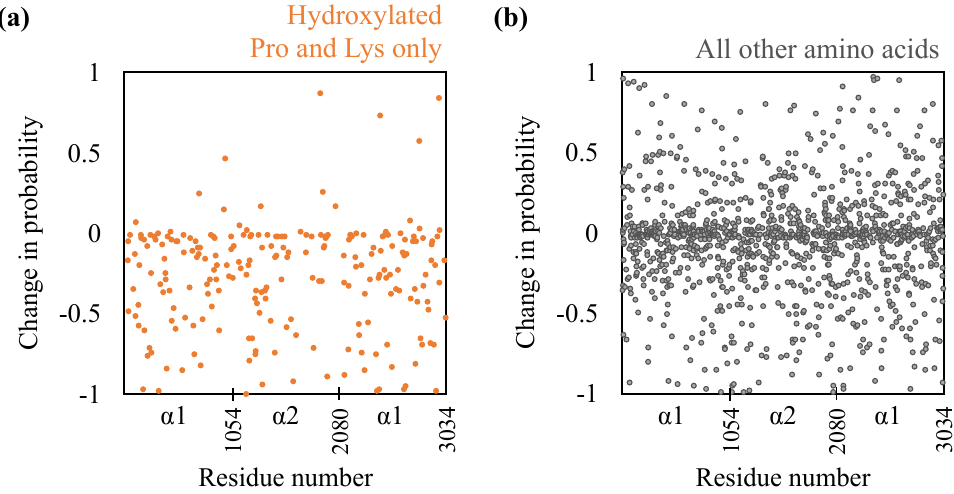
Figure 2. Effect of de-hydroxylation on inter-monomer hydrogen bonding probabilities ( a ) of only those prolines and lysines that are hydroxylated and ( b ) the rest of the amino acids. A negative value implies a decrease in probability due to hydroxylation removal. α 1 and α 2 refer to the two chain types in the triple